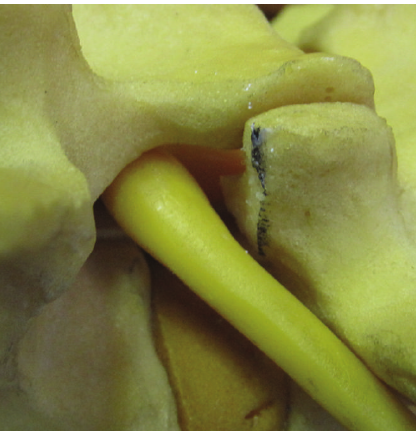
Figure 5: Neuroforamen after resection of bone.